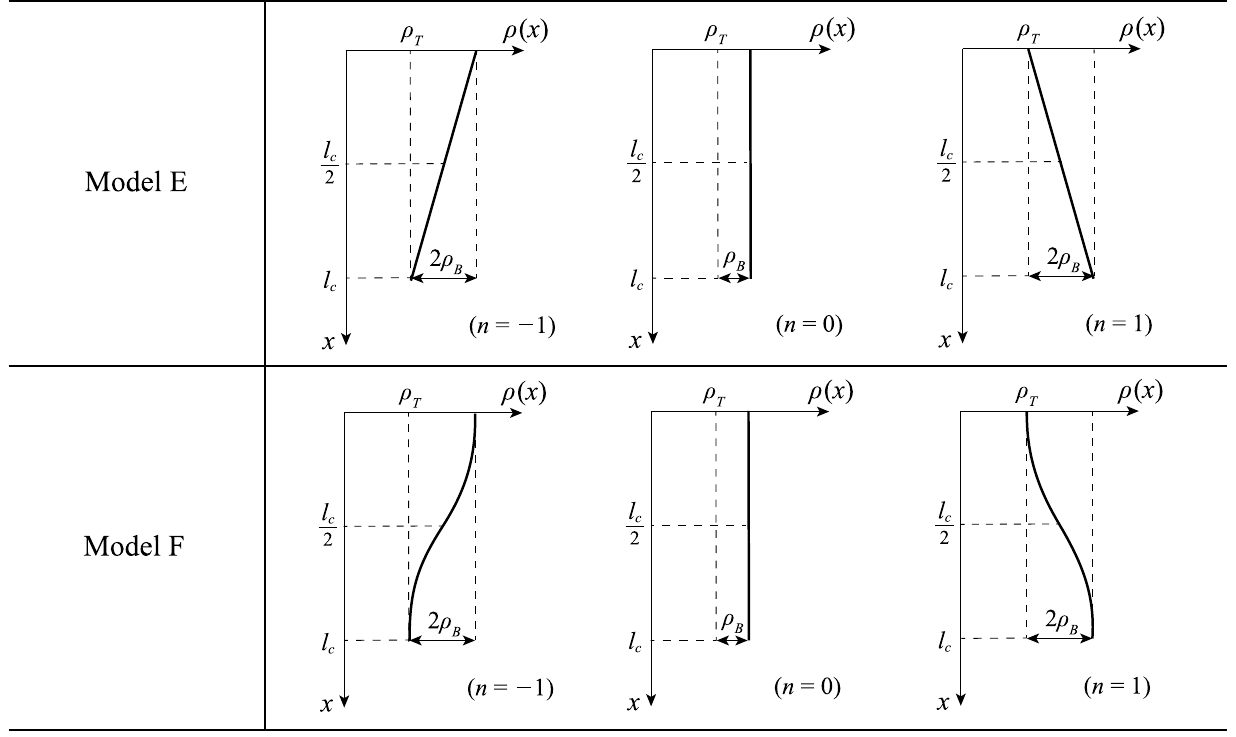
Figure 3. Examples of density distributions representing real